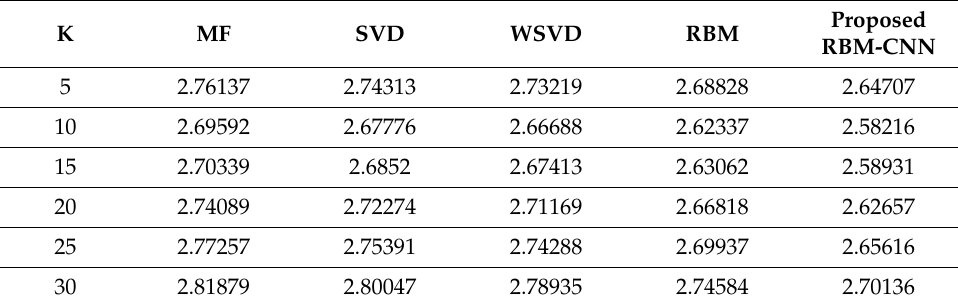
Table 2. Comparison among K and RMSE of di ff erent methods